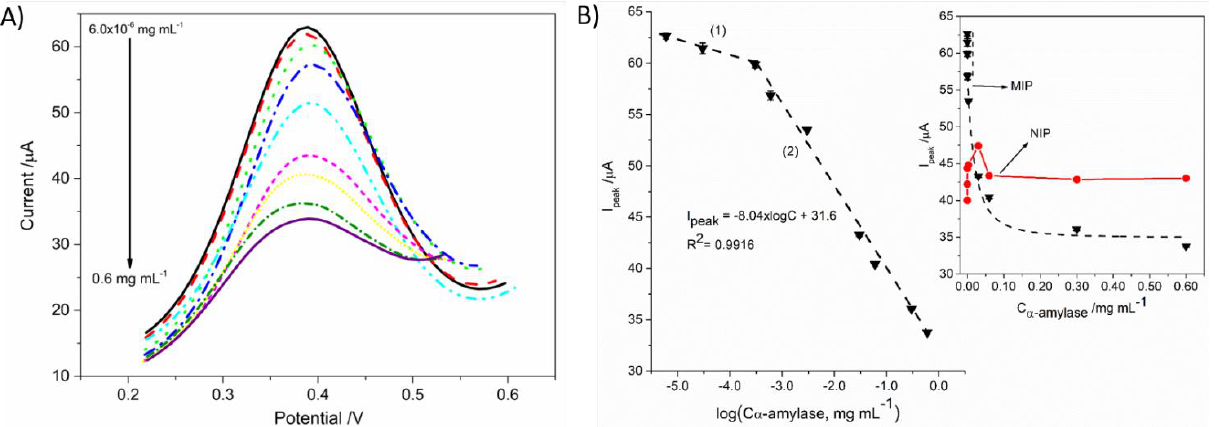
Figure 5. ( A ) SWV measurements, obtained in the presence of 5 mmol L − 1 [Fe(CN) 6 ] 3− / 4− redox couple, at the MIP surface for the several α -amylase standard solutions tested (from 6.0 × 10 − 6 to 0.60 mg mL − 1 ). ( B ) Graphical representation of the redox probe peak current vs. concentration logarithm, obtained at the MIP surface. Inset: Graphical representation of the redox probe peak current vs. α -amylase concentration obtained at the MIP and NIP surfaces. Error bars correspond to standard deviations of analytical signals collected from three independent assays.